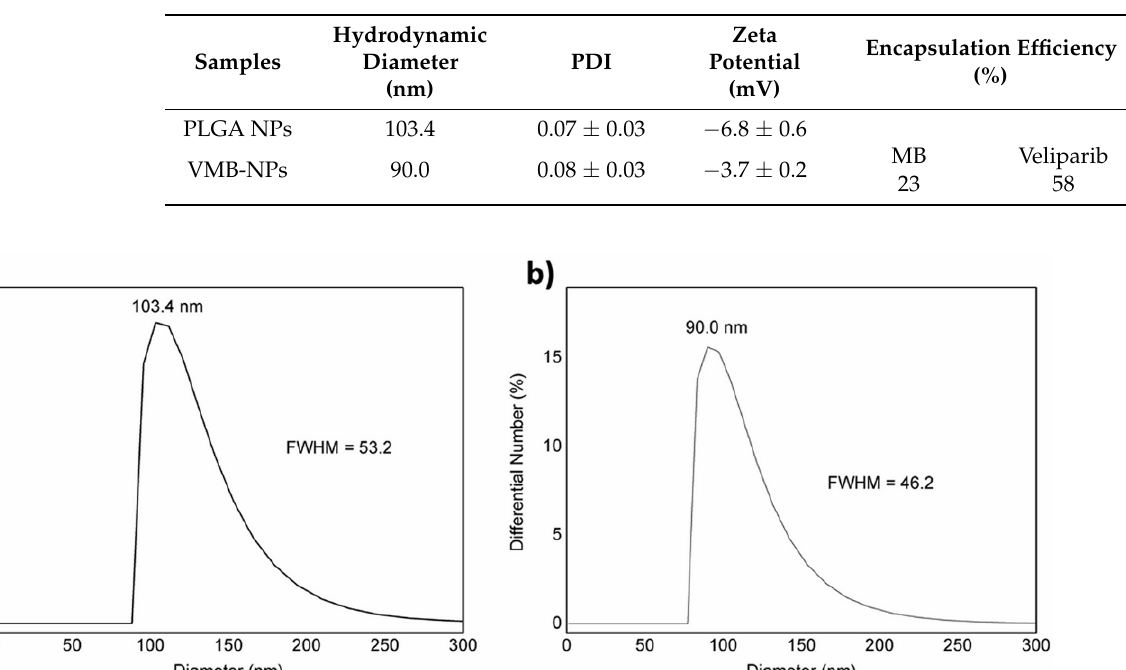
Table 1. Hydrodynamic diameter and zeta potential of PLGA NPs and VMB-NPs, and encapsulation efficiency of MB and veliparib.